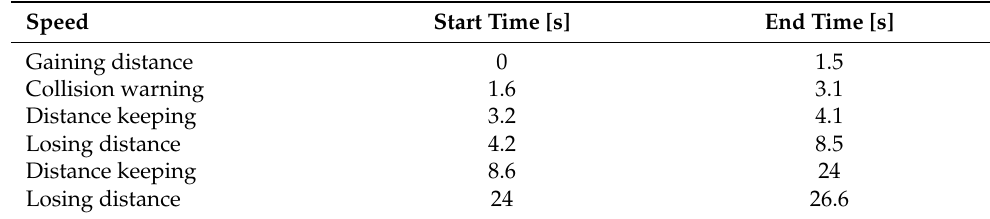
Table 2. Longitudinal maneuvers of the observed